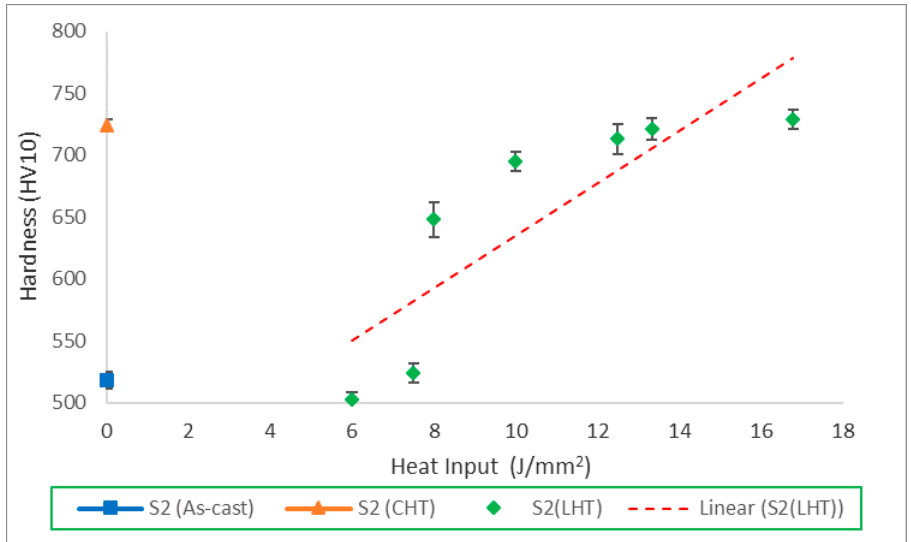
Figure 14. Hardness average values of LHT (S2 sample), CHT and As-cast. Error bars represent standard deviation.